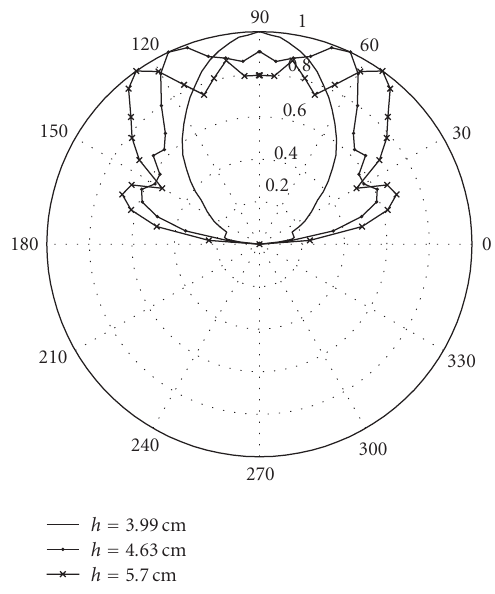
Figure 7: E -plane patterns for h = 3 . 999, 4.63, and